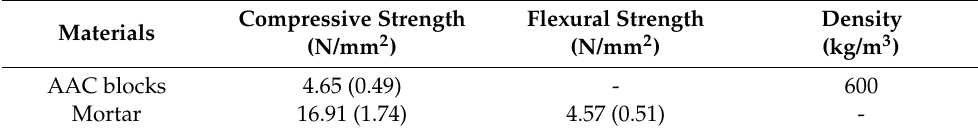
Table 1. Main strength parameters of masonry components.